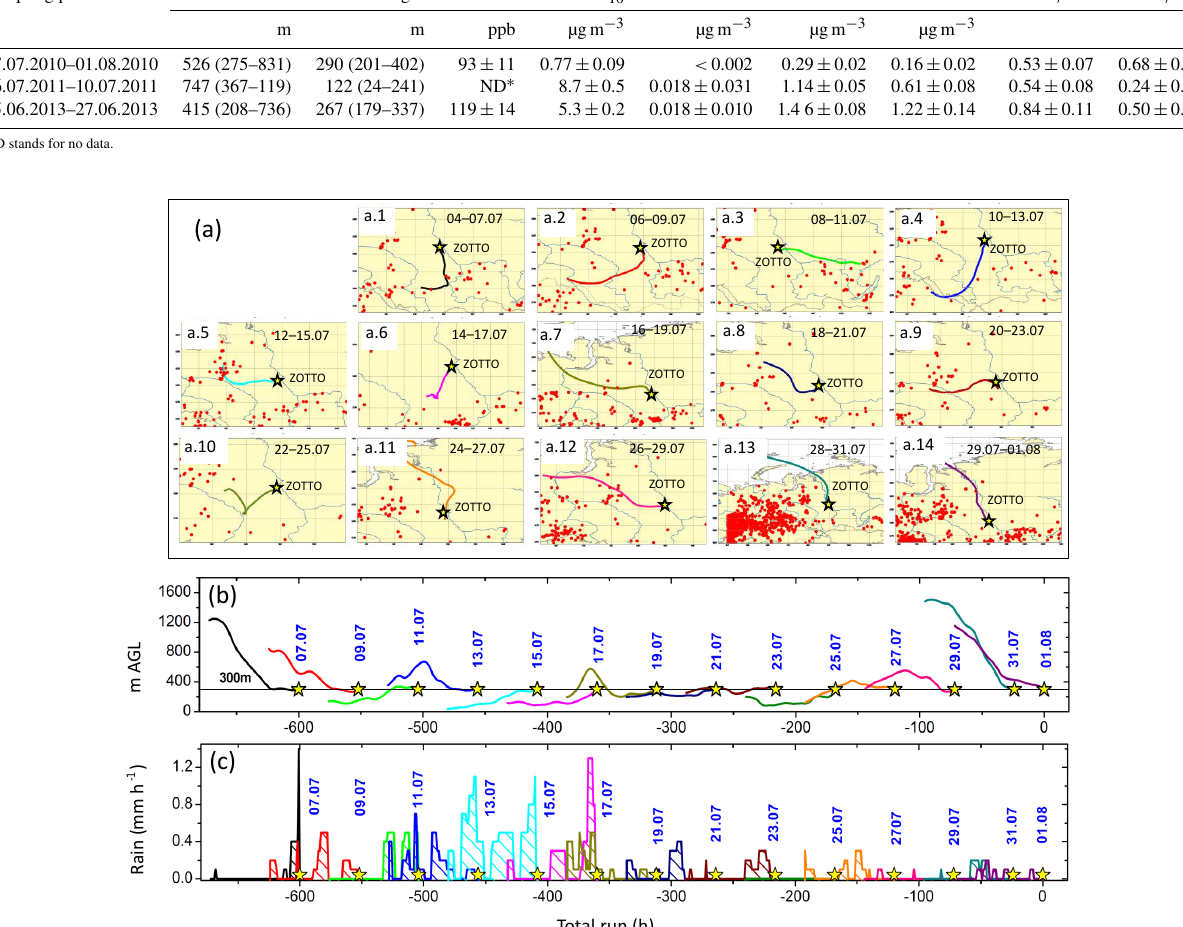
Figure 12. Panel (a) : 72h HYSPLIT air mass trajectories with 48h intervals during background periods at ZOTTO at 300m from 7 July to 1 August 2010; red dots indicate the fire locations within a 72h period. Panel (b) : their height above ground level (a.g.l.) and (c) precipitation rate along the air mass trajectories. Stars and dates show the arrival time of the air masses (b, c)